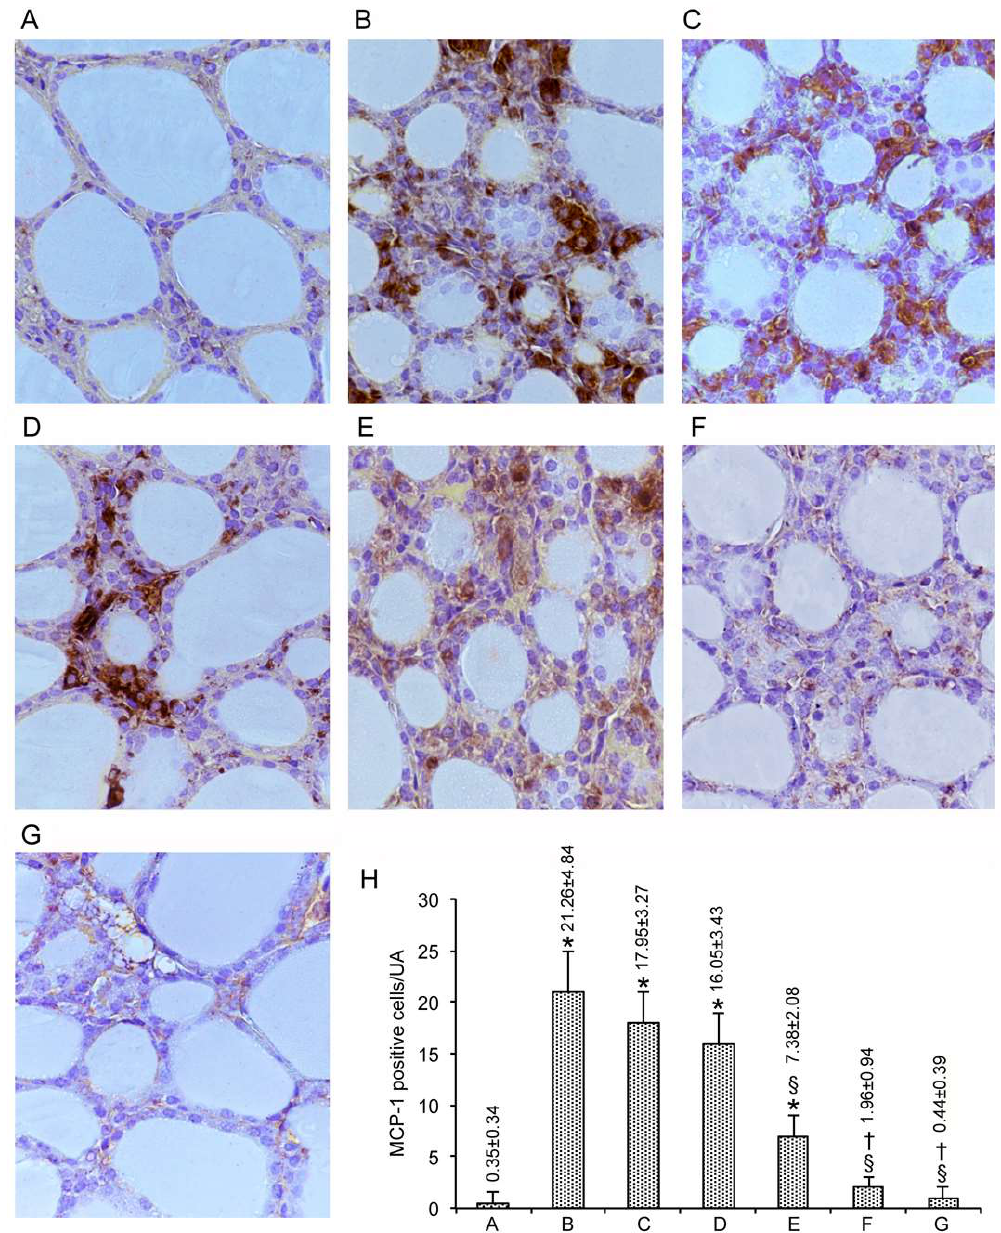
Figure 3. Immunohistochemical expression of monocyte chemoattractant protein-1 (MCP-1) in the thyroid (scale bar: 25 µ m). Mice groups are as in Figure 1. ( A ): In controls, no MCP-1-positive cells are present, as shown by bar A in H. ( B ): CdCl 2 -treated mice show a marked increase in MCP-1 immunoreactivity, as indicated by bar B in H; positive cells line the follicle wall with strong stains on their cytoplasm. ( C-D ): In mice treated with CdCl 2 plus 0.2 mg/kg Se or CdCl 2 plus 0.4 mg/kg Se, the number of MCP-1-positive cells is decreased, but still higher than controls, as evidenced by bars C and D in H. ( E ): CdCl 2 plus MI-treated mice, MCP-1-positive cells are fewer, as shown by bar E in H, and show reduced cytoplasmic staining. ( F-G ): In the thyroid of mice treated with CdCl 2 plus MI and 0.2 mg/Kg Se or CdCl 2 plus MI and 0.4 mg/kg Se, MCP-1 immunoreactivity is significantly decreased, as indicated by bars F-G in H. ( H ): The number of MCP-1-positive cells per microscopic field in the different groups of mice (mean ± standard error). * p < 0.05 versus control; § p < 0.05 versus CdCl 2 plus vehicle and CdCl 2 plus 0.2 or 0.4 mg/kg Se; † p < 0.05 versus CdCl 2 plus MI.